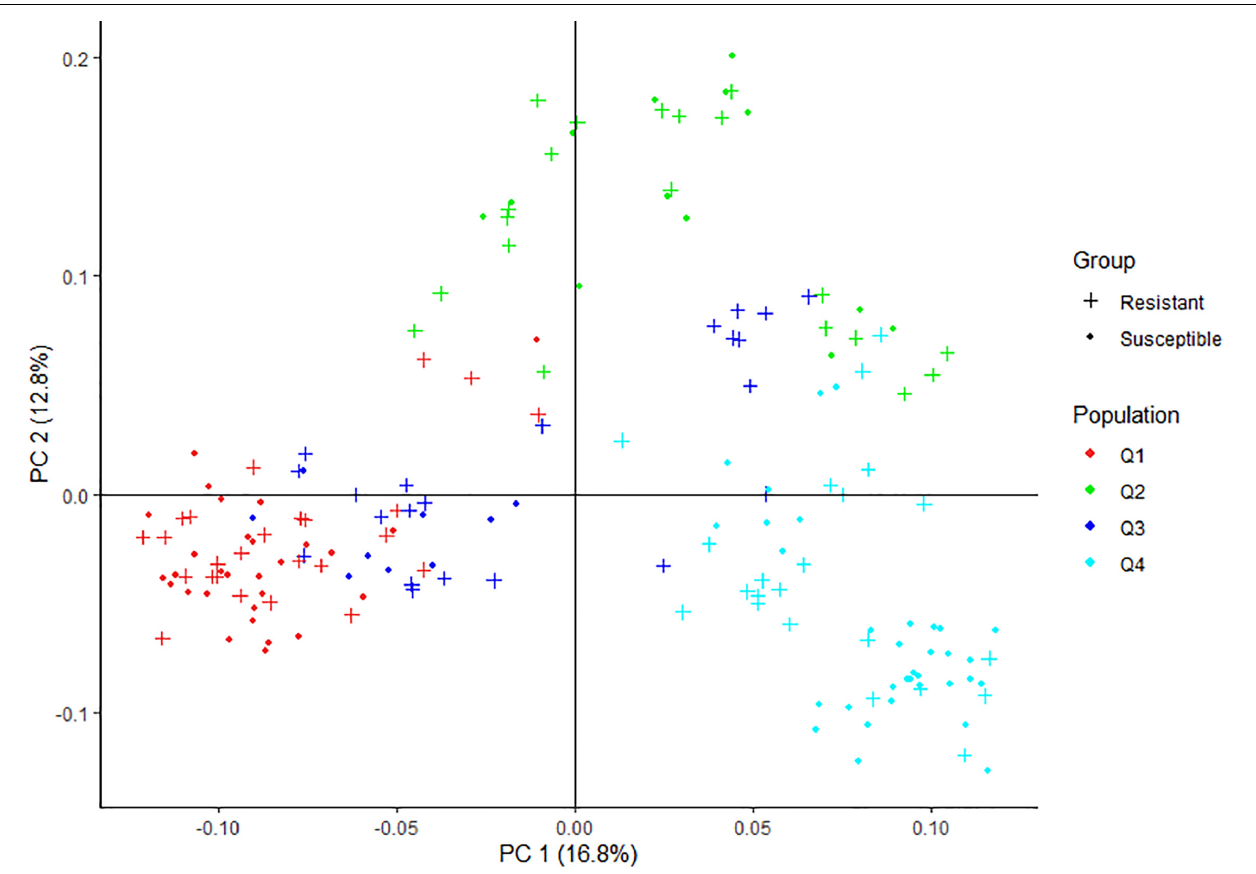
FIGURE 4 | Graphical plot of the principal component analysis (PCA) of the spinach lines in the association panel. The horizontal and vertical axis are the first and second principal components (PC), and the variance explained by each PC is noted. Colors correspond to members of subpopulation Q1 (red), Q2 (green), blue (Q3), and turquoise (Q4). Resistant and susceptible genotypes are presented by “plus” and “filled circle” signs. The same colors were used for the subpopulations generated from ADMIXTURE and PCA plot in Figures 2 , 3